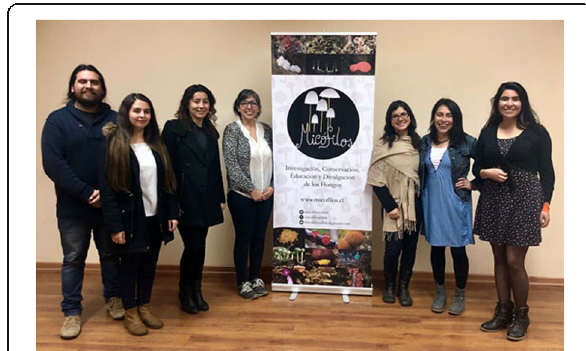
Fig. 6 The organizing team from Micófilos ( left to right ): Christian